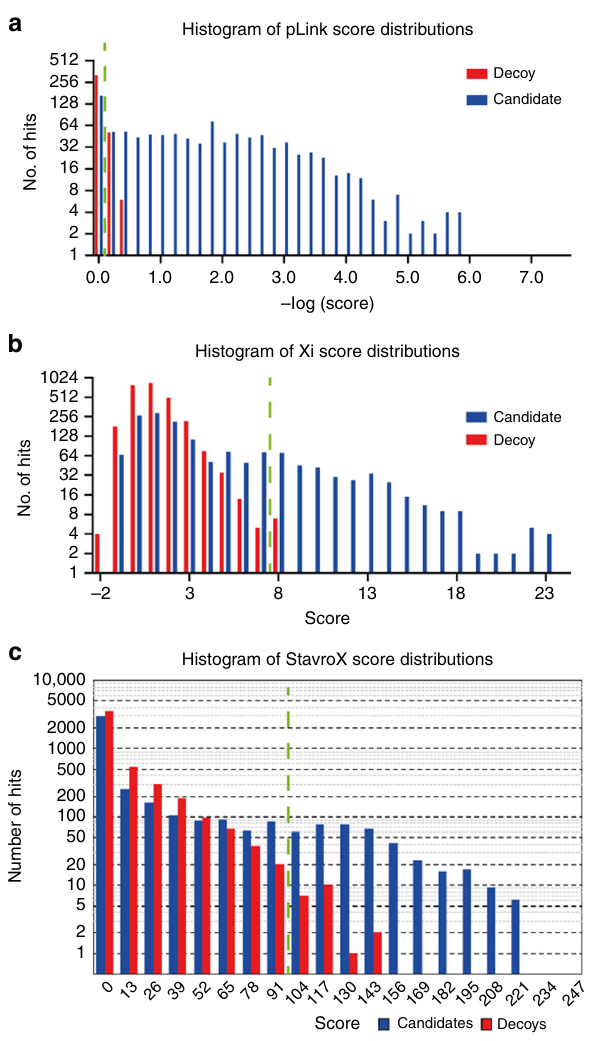
Fig. 5 Score distributions for candidate and decoy crosslinks given by search algorithms. a pLink, b Xi and c StavroX. Here, the true-positive and false-positive crosslinks are grouped as candidates. Green dashed line refers to the score cut-off used to fi lter for an estimated 5% FDR.